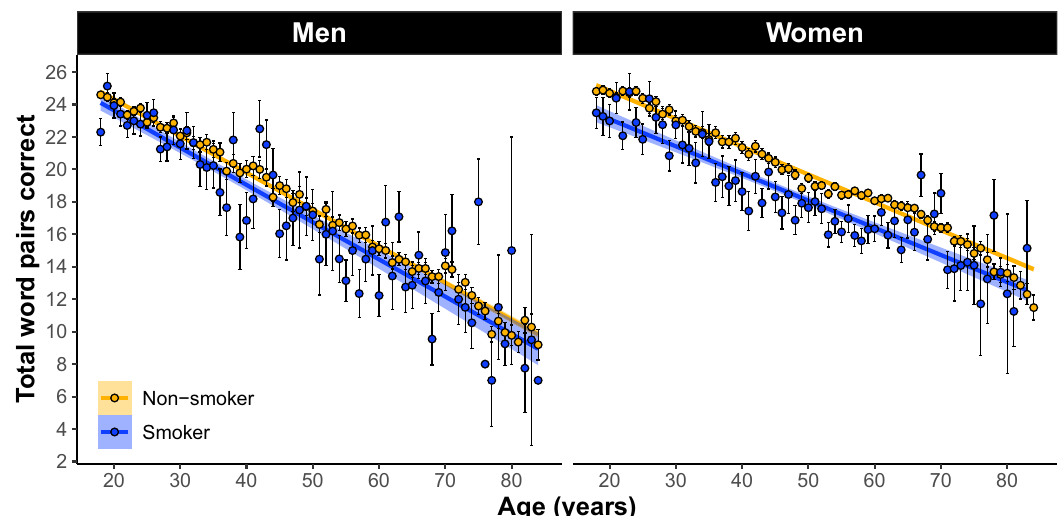
Figure 2. The main effect of self-reported smoking status on PAL performance across 18–85 year olds separately between men and women. Simple effects analyses revealed that women’s memory is negatively impacted by smoking (β = − 1.01 word pairs, std error = 0.14, p = 7.83e−13; ( B )) whereas men’s is not significantly impacted (β = − 0.27 word pairs, std error = 0.18, p = 0.135: ( A )). Shown are the linear regression fit lines (± 95% confidence interval (CI)) of the PAL total number of correct from 18 to 85 years